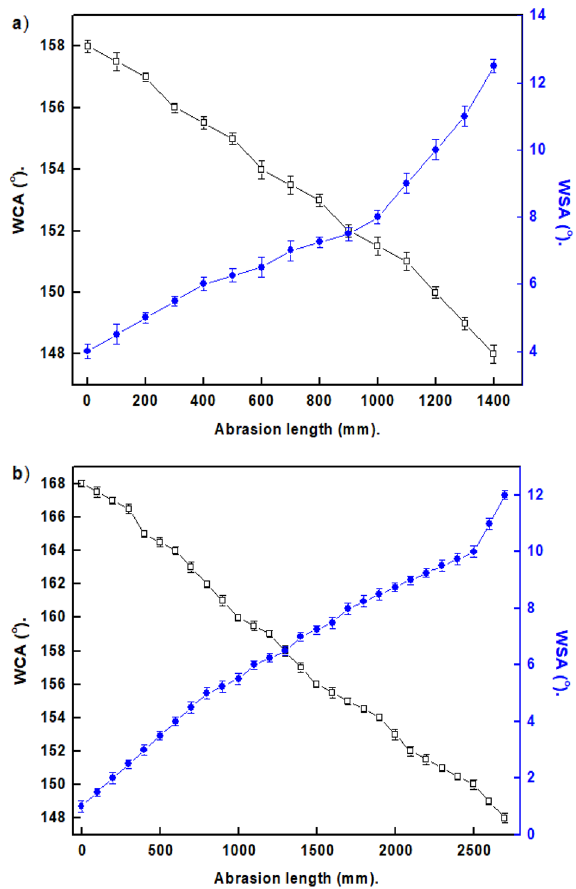
Figure 9. The change in WCAs and WSAs against the abrasion length for coated steel with ( a ) Ni@G@MA and ( b )